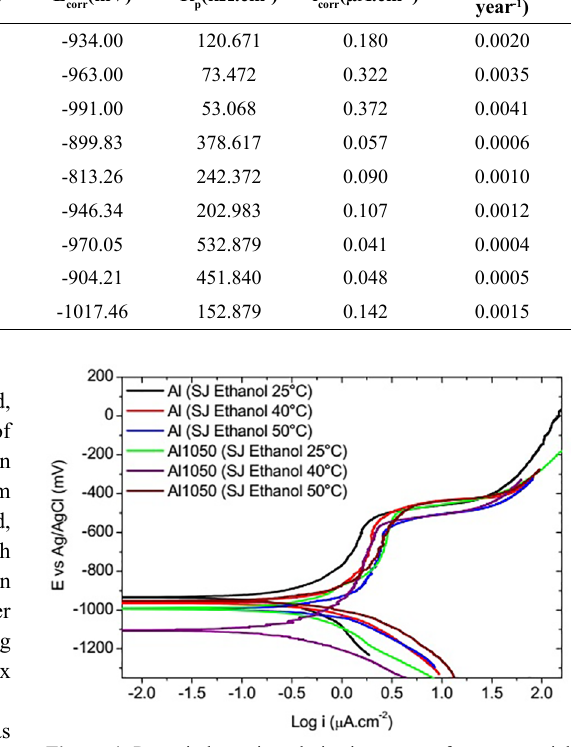
Table 3. Electrochemical parameters obtained through extrapolation of Tafel for commercial grade aluminum. Alloy